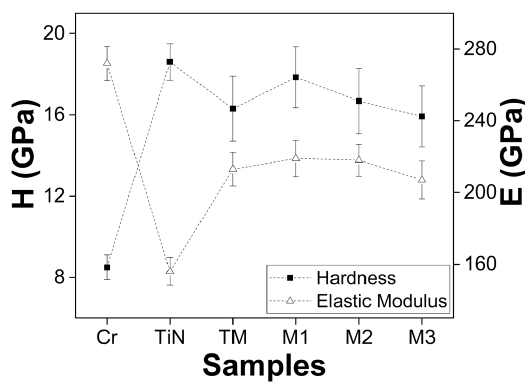
Figure 6. Hardness and elastic modulus of as deposited TiN/Cr coatings.